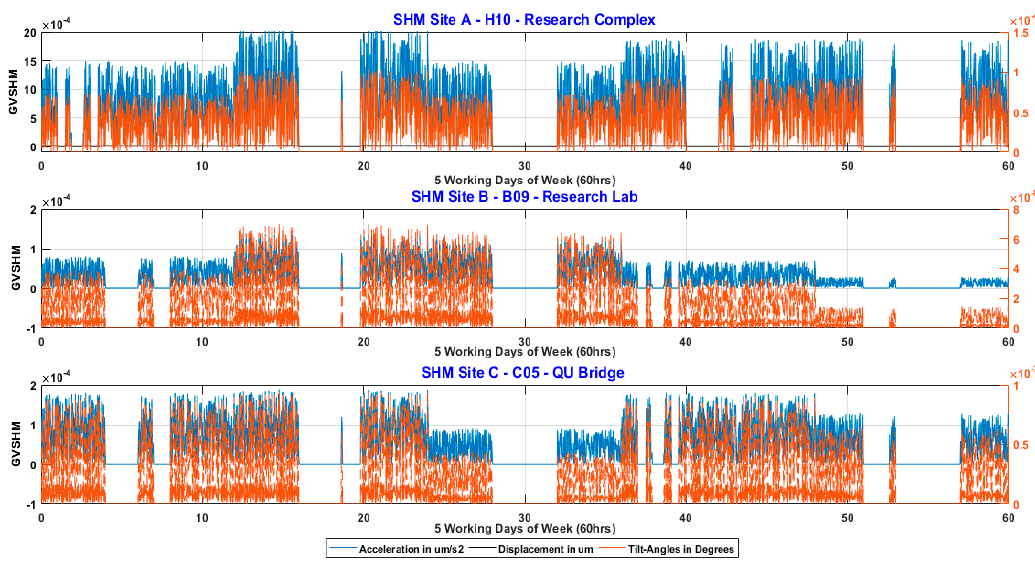
Figure 12. Private Cloud SHM ‐ UCM Filtered Data for 60 days.